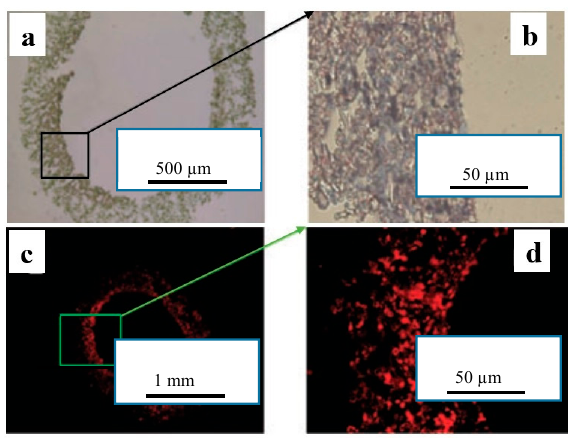
Figure 9. Expression of transgene eNOS protein in both MSCs seeded blood vessel ( a , b ) and eNOS- MSCs seeded blood vessel ( c , d ) (reprinted from Ref. [84]).